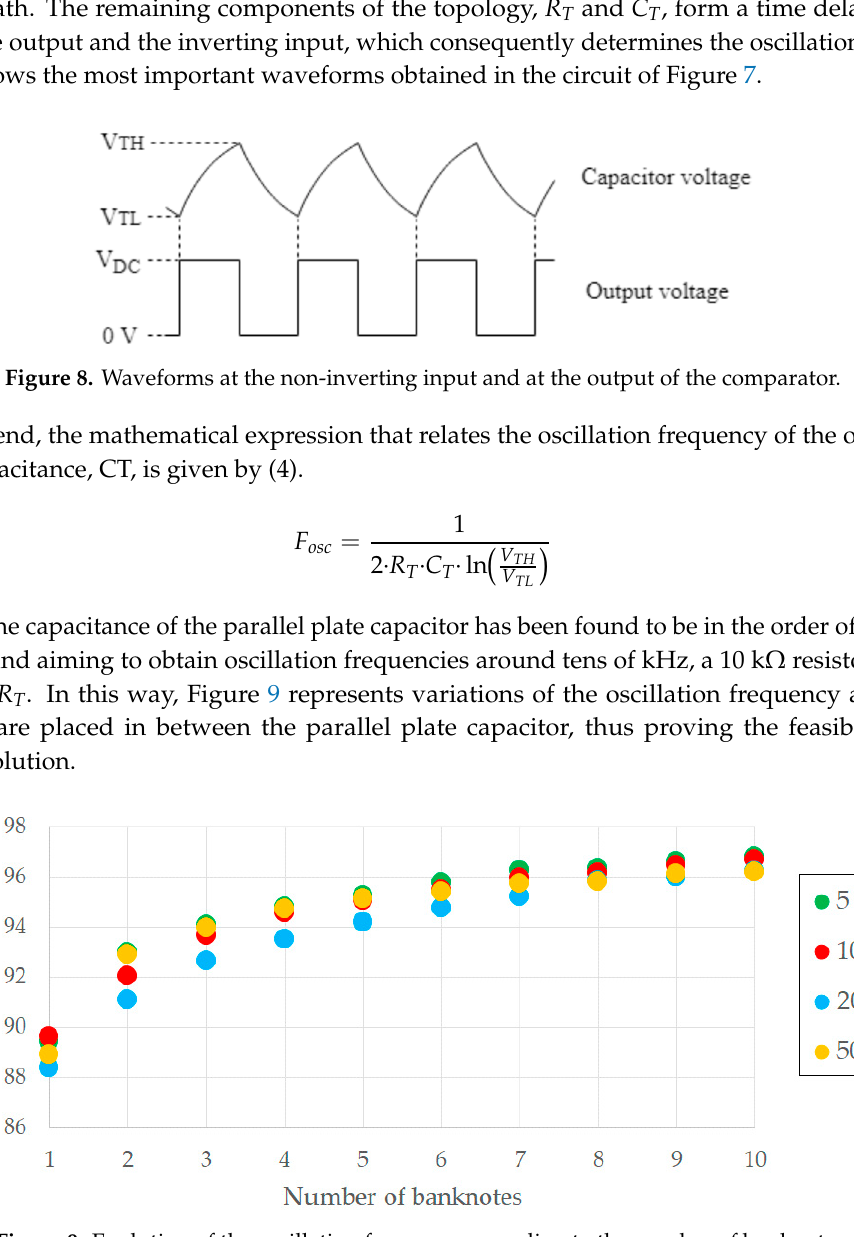
Figure 9. Evolution of the oscillation frequency according to the number of banknotes.